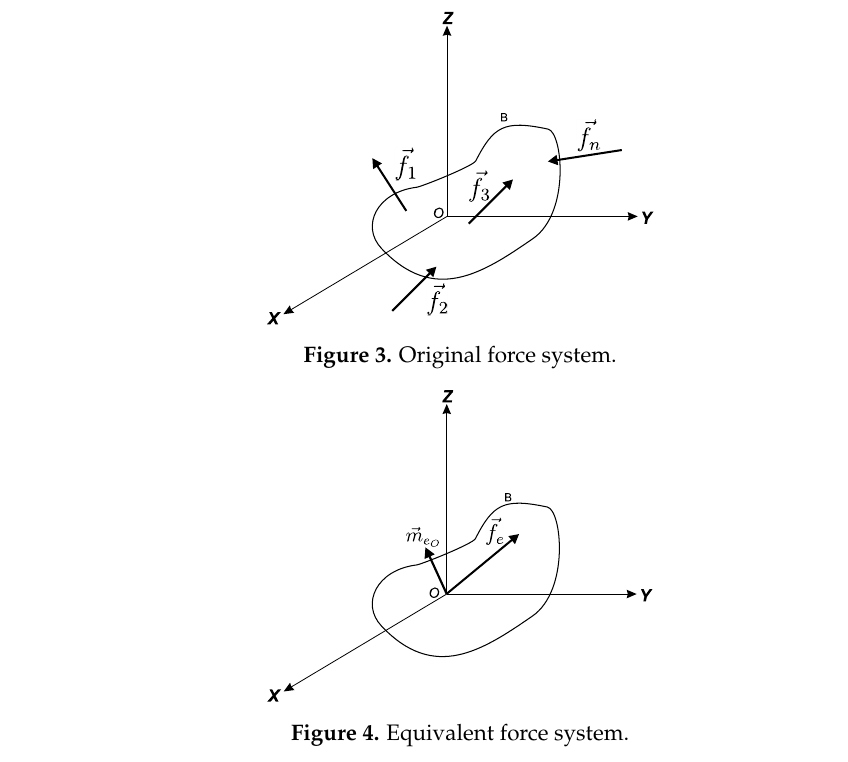
Figure 3. Original force system.